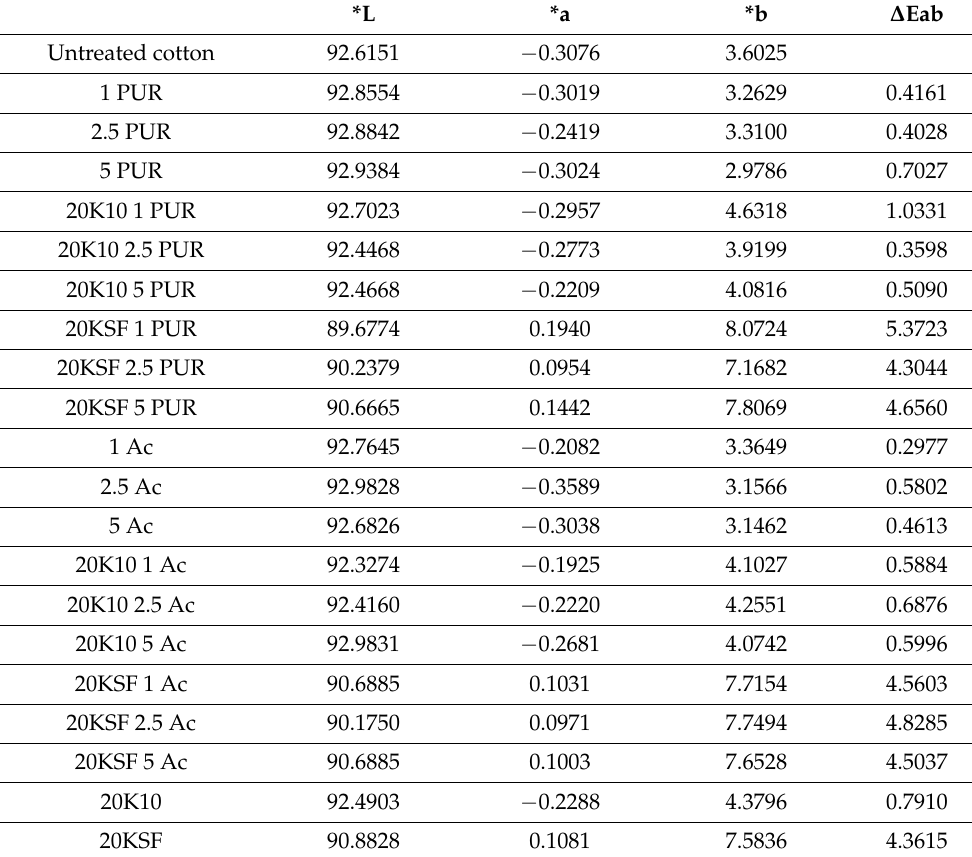
Table 3. CIELAB color space colorimetric parameters of the treated